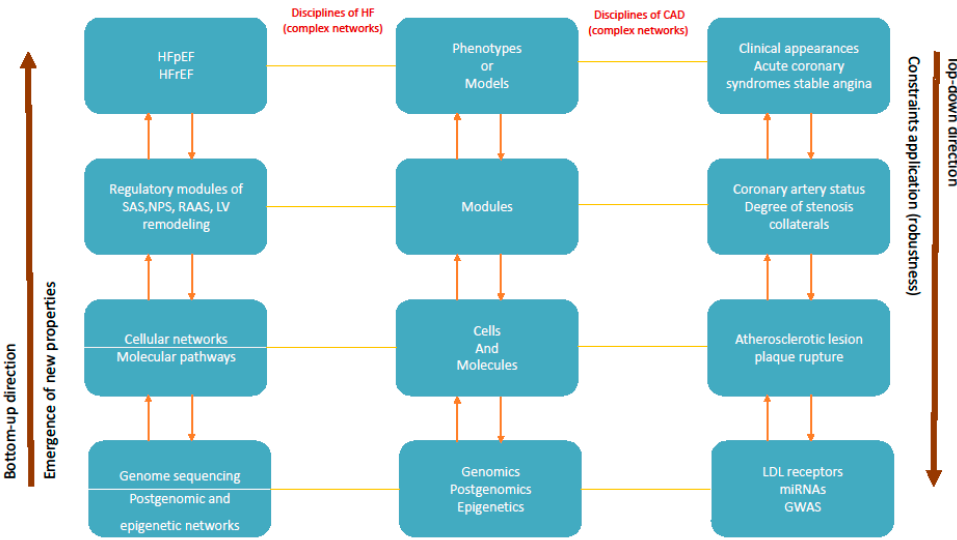
Figure 3. Progression of coronary artery disease and heart failure from systems biology perspective: application of systems biology concepts in HF and CAD progression. HF =heart failure; HFpEF = heart failure with preserved ejection fraction; HFrEF = heart failure with reduced ejection fraction; SAS = sympathetic adrenergic system; NPS = natriuretic peptide system; RAAS = renin -angiotensin- aldosterone system; LV = left ventricle; CAD = coronary artery disease; LDL = low density lipoprotein; miRNAs = microribonucleic acids; GWAS = genome wide association studies.